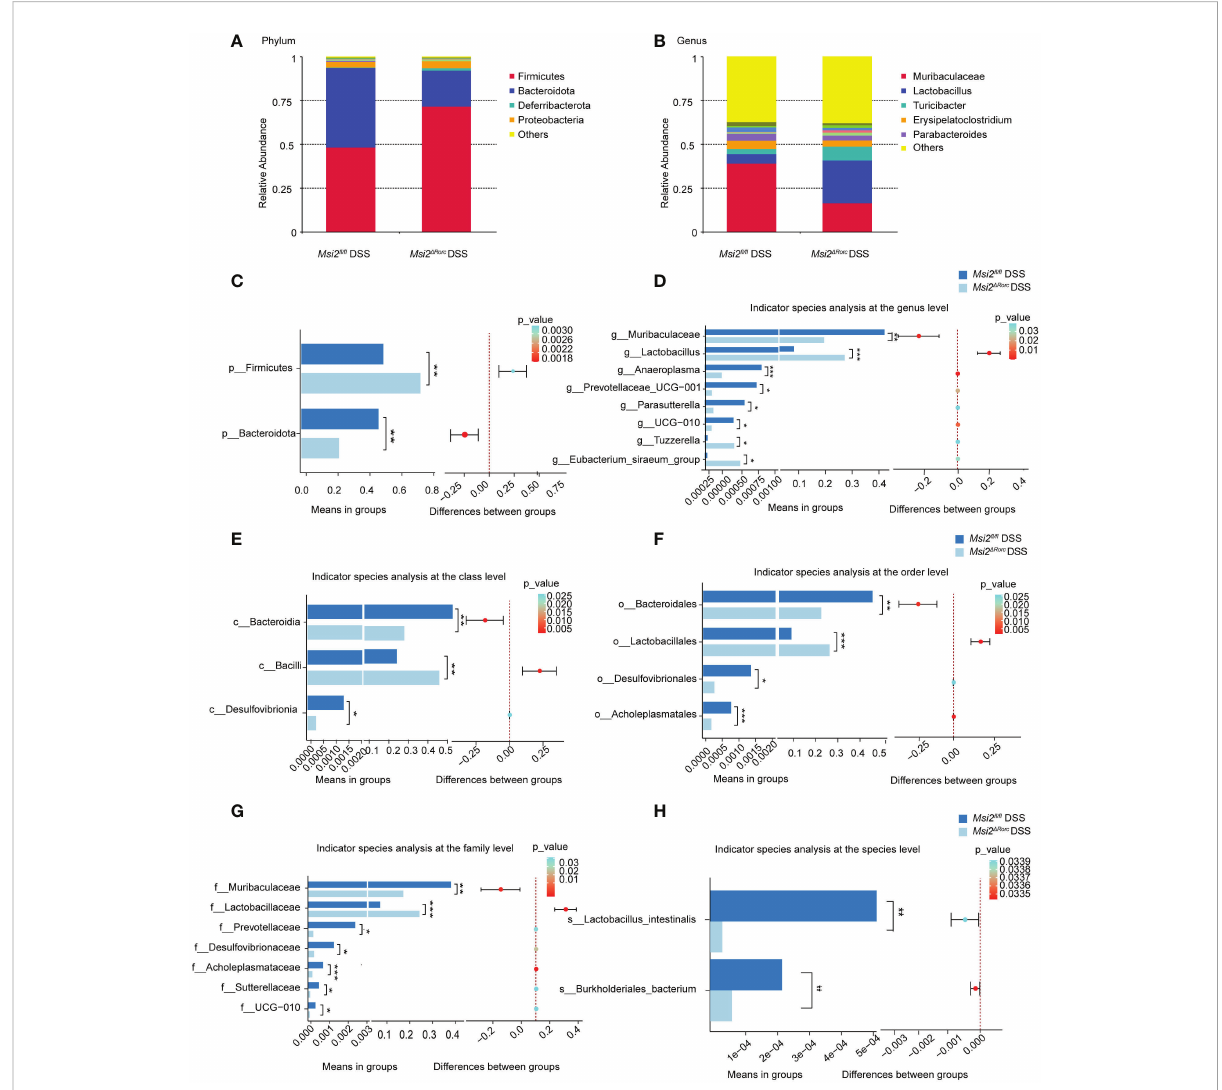
FIGURE 7 Changes in the intestinal microbiota composition between the two groups. Changes in the relative abundances of the dominant intestinal microbiota were observed at the (A, C) phylum and (B, D) genus levels between the Msi2 fl / fl DSS group and the Msi2 D Rorc DSS group. Differentially abundant intestinal microbiota at the (E – H) class, order, family, and species levels were observed between the Msi2 fl / fl DSS group and the Msi2 D Rorc DSS group. ASVs and taxon differences were identi fi ed with p values less than 0.05 (n=8). *p < 0.05, **p < 0.01, ***p <